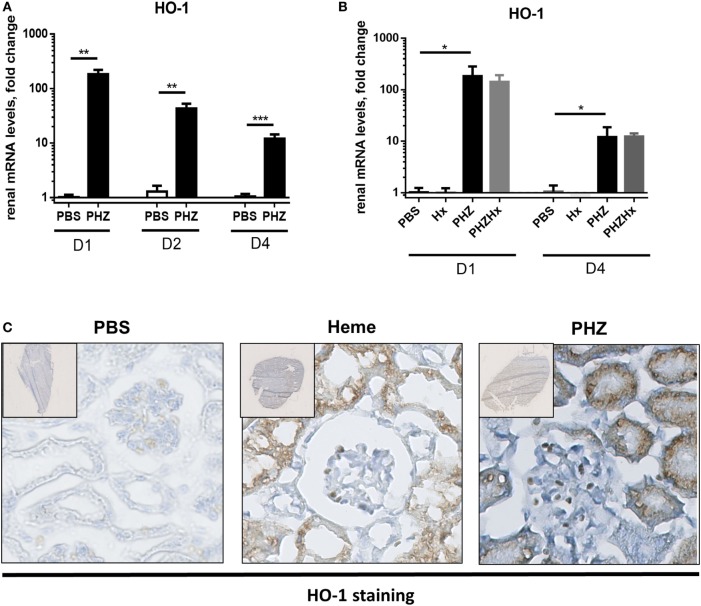
Heme oxygenase 1 (HO-1) expression induced in tubular kidneys in response to hemolysis. (A) Kinetics of mRNA levels in renal tissue of HO-1 at days 1, 2, and 4. ** p < 0.005, *** p < 0.001, and Mann–Whitney test. (B) HO-1 expression at days 1 and 4 was not modulated by hemopexin (Hx); * p < 0.05, Kruskal–Wallis with Dunn’s test for multiple pairwise comparisons. (C) Immunohistochemistry analysis of frozen kidney sections of mice (×20), injected with phenylhydrazine (PHZ), heme, or with the vehicle only at day 2. The staining for HO-1 appears in brown and nuclei in blue. Representative images from one out of three or five mice per group (staining performed in three independent experiments).